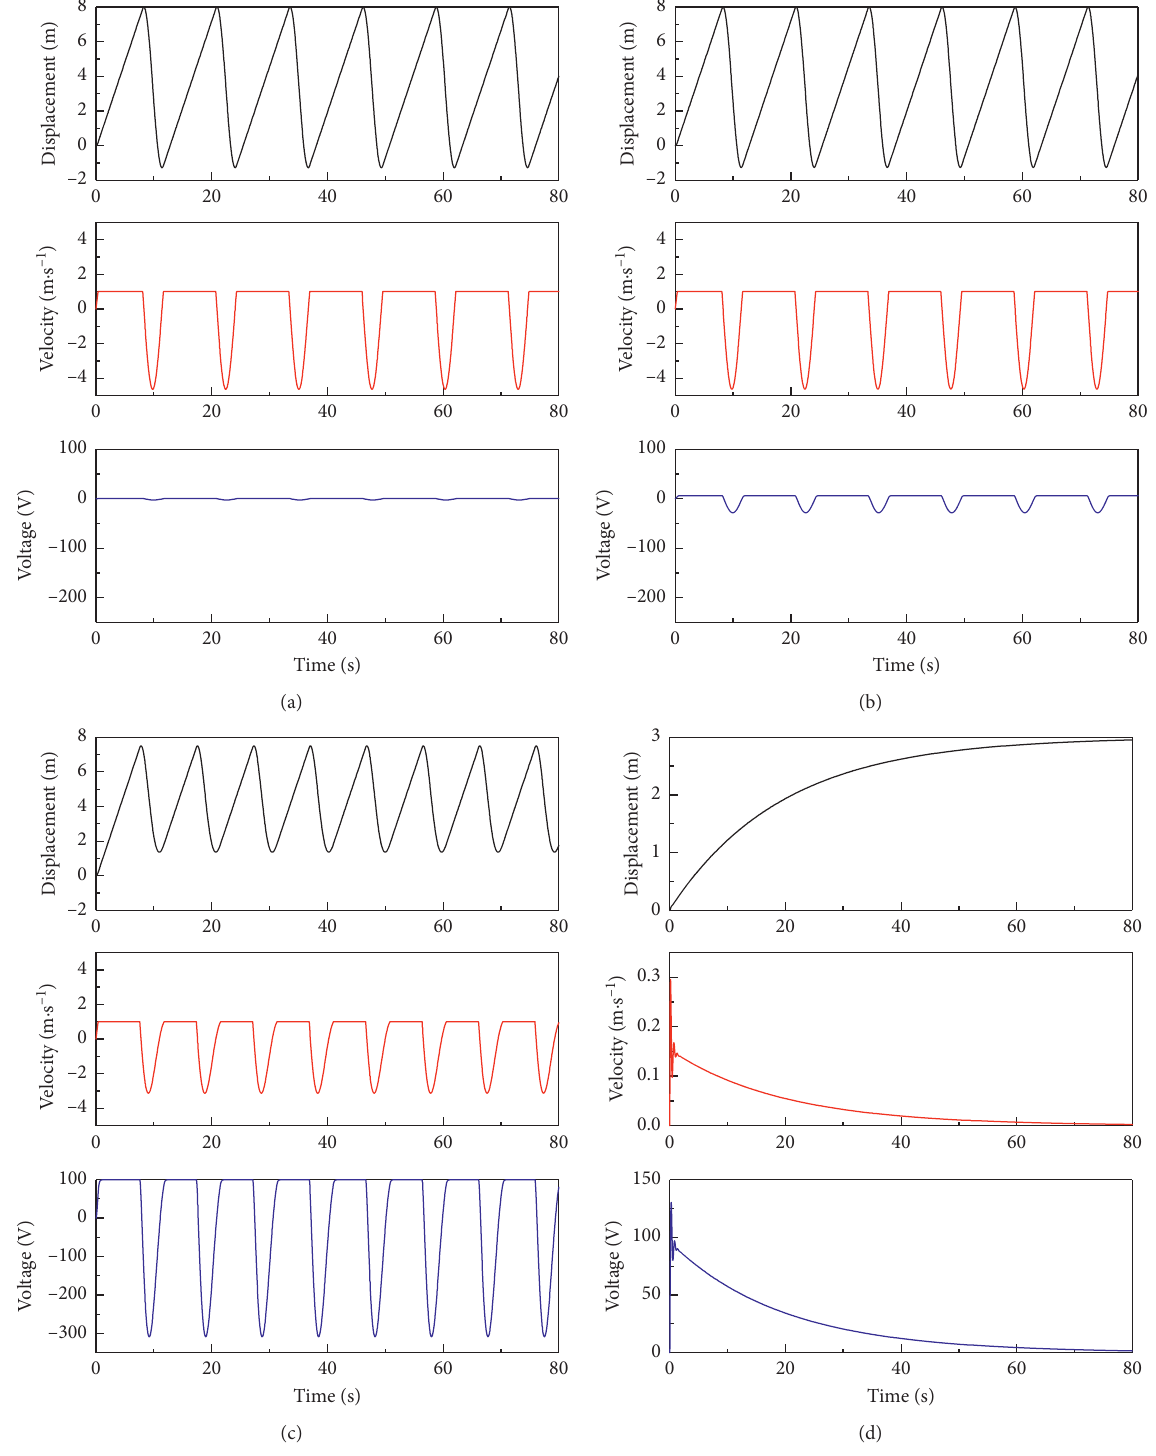
Figure 13: The displacement, velocity, and output voltage of the friction system when the force factor of piezoelectric element is α � 3.1 × 10 − 5 N/V (a), α � 3.1 × 10 − 4 N/V (b), α � 5 × 10 − 3 N/V (c), and α � 3.1 × 10 − 2 N/V (d) in the friction law